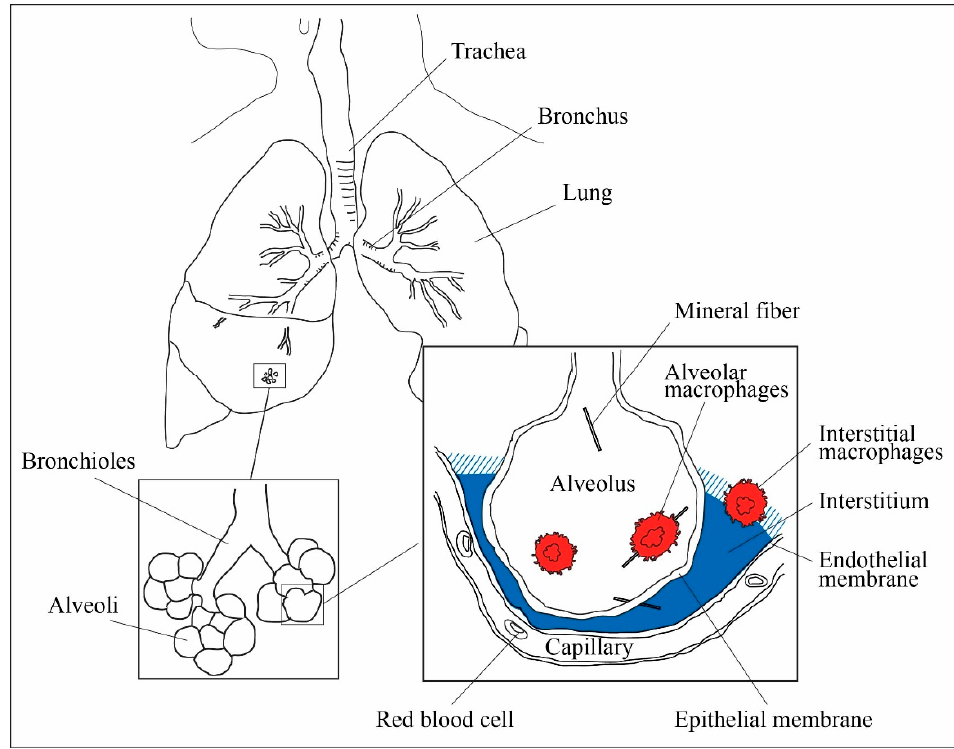
Figure 1. Schematic image of lung environment and, in particular, of the alveolus, reachable by small inhaled fibres. Artificial lysosomal fluid (ALF) solution simulates the acid environment inside the alveolar and interstitial macrophages (in red), while Gamble’s solution simulates the neutral environment of interstitial fluid (blue).